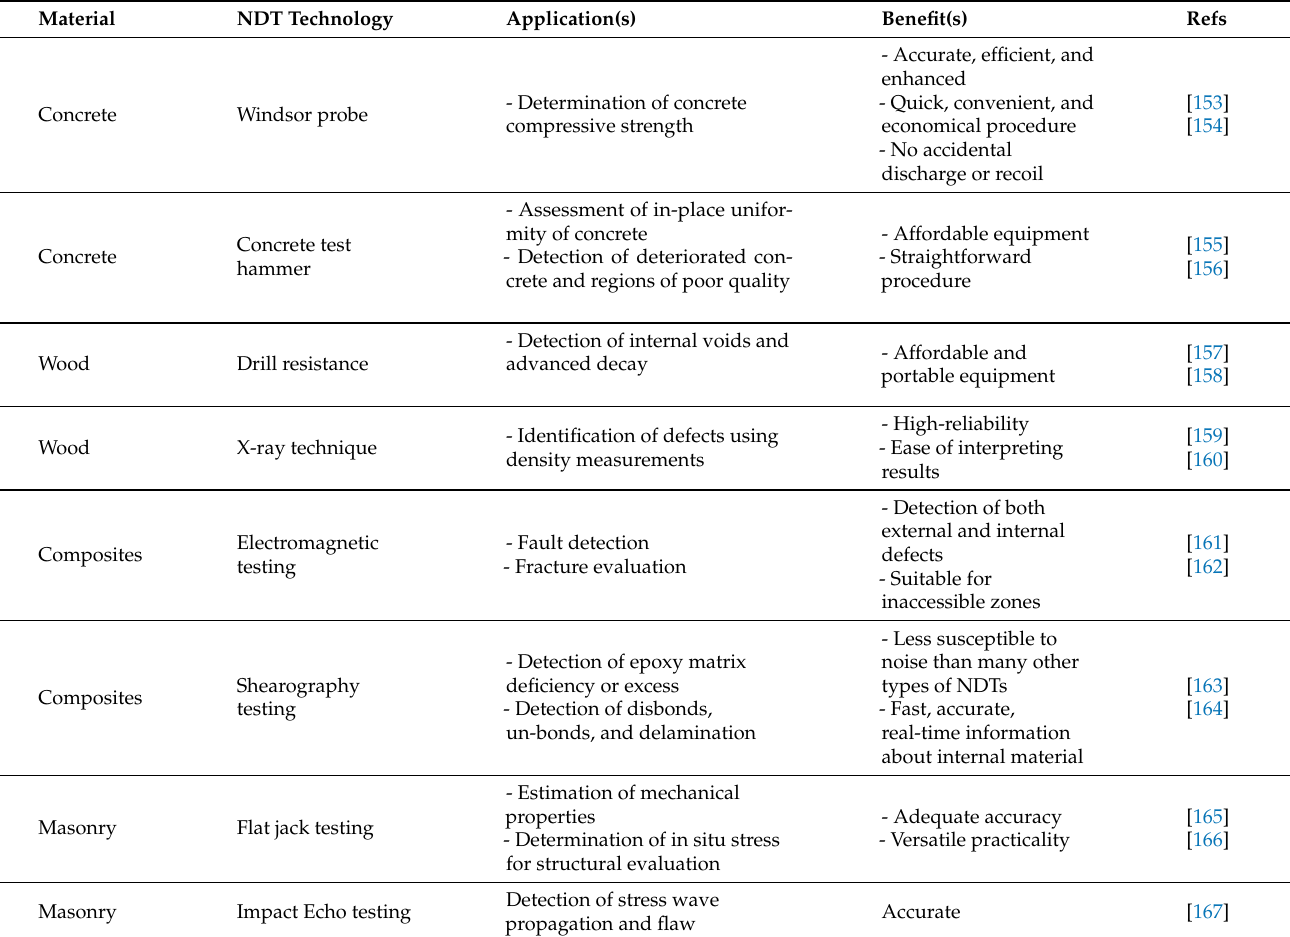
Table 7. Common NDT technologies, applications, and benefits used for concrete, wood, composites, and